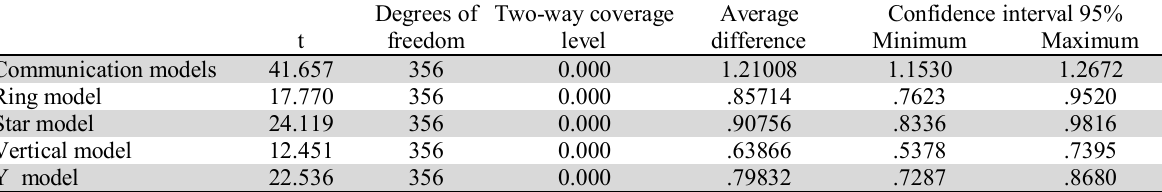
The summary of t-student test (test amount =